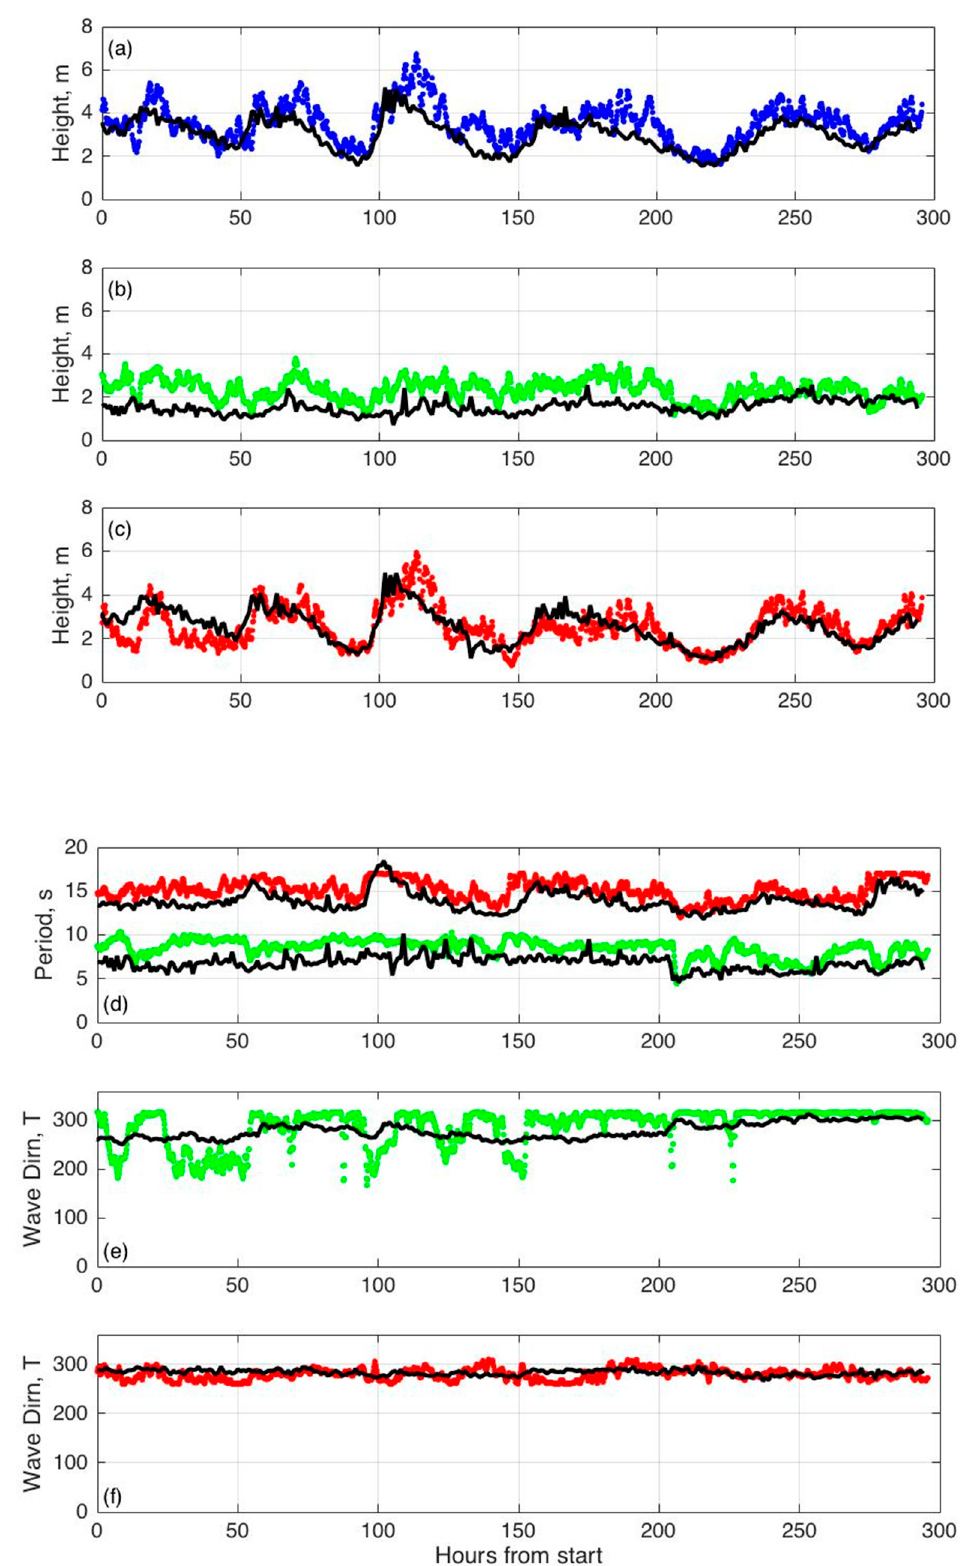
Figure 5. Wave parameters plotted vs. time. Buoy parameters are plotted in black. Radar parameters are plotted as follows: ( a ) Total waveheight (blue), ( b ) Wind-wave height (green), ( c ) Swell waveheight (red), ( d ) Wave period: Wind-wave (green), Swell (red) ( e ) Wave direction Wind-wave (green) ( f ) Wave direction Swell (red). Start time: 12:00 p.m., 6 January